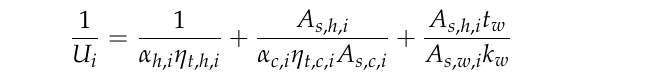
the heat exchanger, respectively.